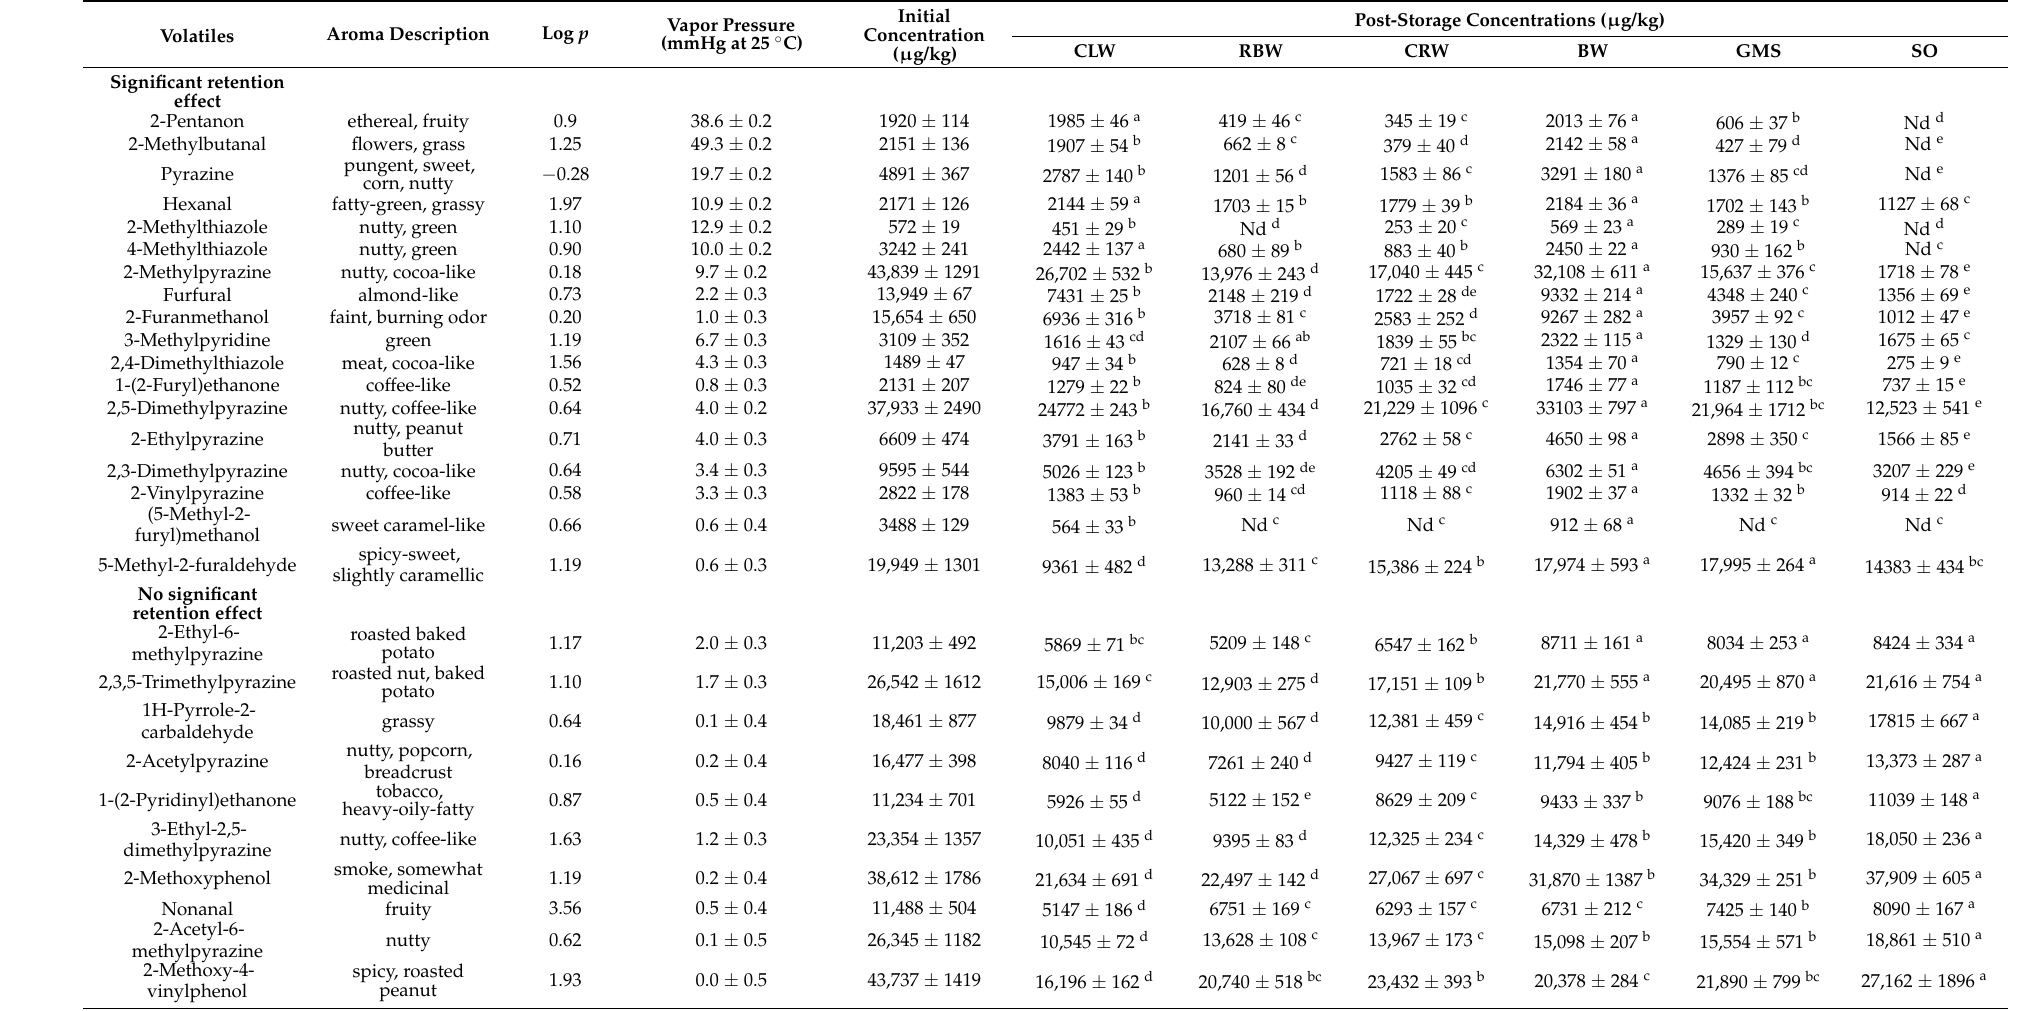
Table 2. Changes in the content of the main volatile compounds in samples before and after storage ( µ g/kg, mean ±